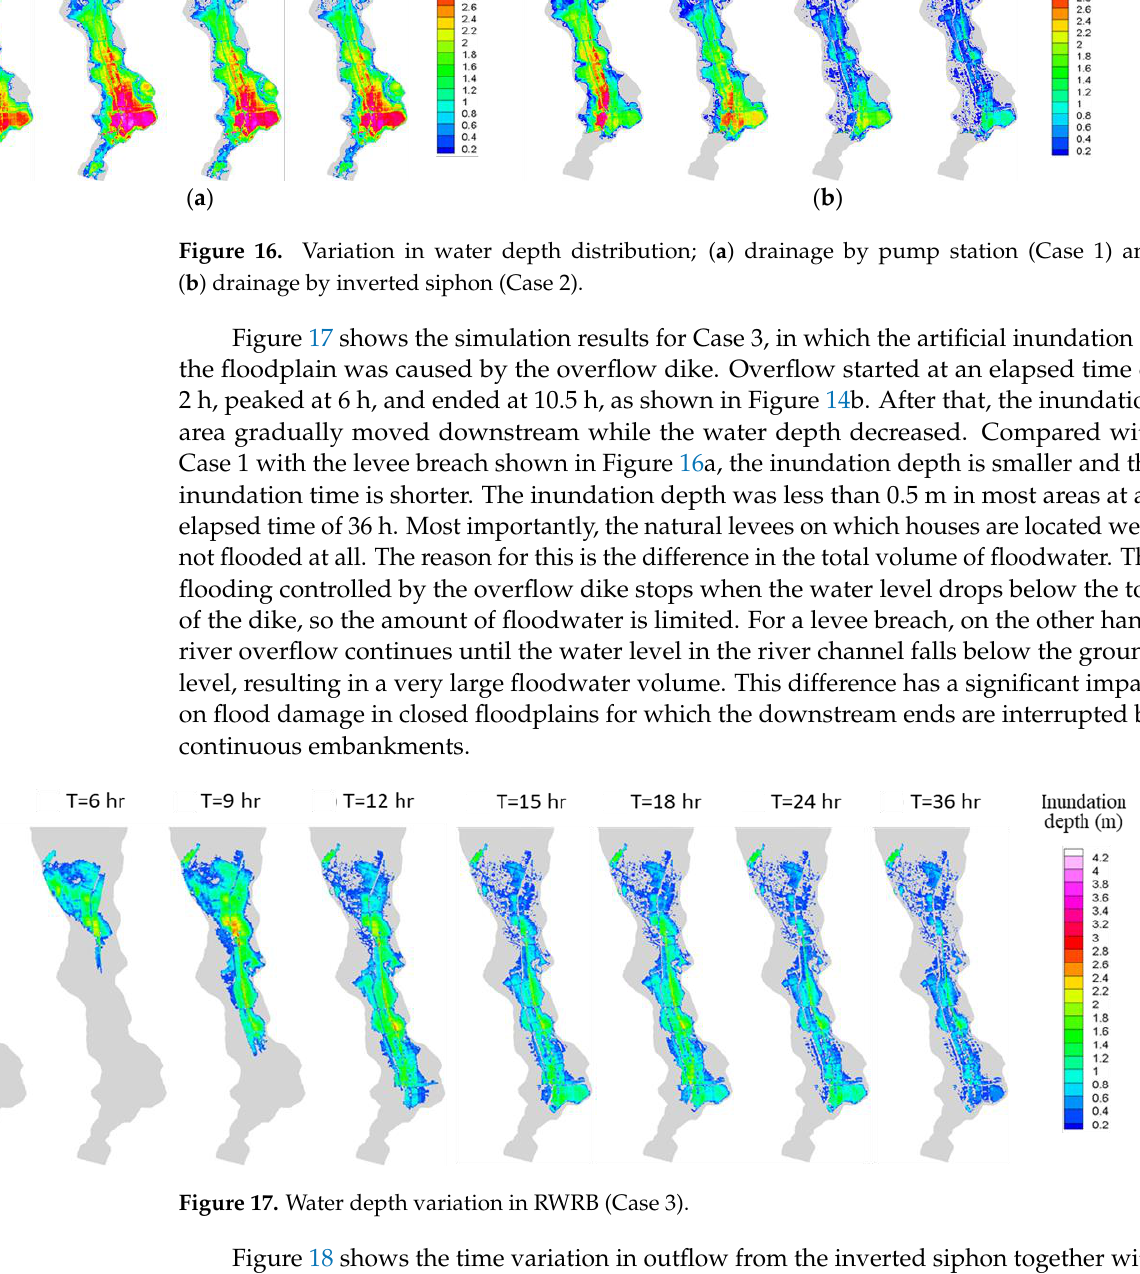
Figure 18. RWRB performance for excess flood mitigation. Using Manning ’ s equation for a shallow, wide channel shown below, the dimension of the drainage channel cross section required for flow at the above-mentioned discharge was approximated. 𝐵 = 𝑛𝑄 ℎ 5/3 𝐼 1/2 (12) where B is the channel depth, Q is the flow rate (240 m 3 /s), h is the flow depth, n is Manning ’ s roughness coefficient of the concrete channel (0.012), and I is the slope (1/3000). Under the assumption that h = 2 m, the obtained B value was about 50 m. Most of the Old Kinu River Floodplain is used for rice cultivation and thus the floodplain has many agricultural irrigation canals, which can be used to carry some of the discharge from the inverted siphon. However, the canals are divided into many narrow channels, so the water will overflow to the surrounding paddy fields while flowing in the channels. Therefore, the water storage capacity of paddy fields must be considered. The total volume of water discharged from the inverted siphon shown in Figure 18 is approximately 10 million m 3 and the area of the Old Kinu River Floodplain is at least 40 km 2 (2 km × 20 km); therefore, even if all the floodwater from the inverted siphon is stored in the floodplain, the average water depth would be 25 cm, which is shallower than the standard ridge height (30 cm) of rice paddy fields in Japan.